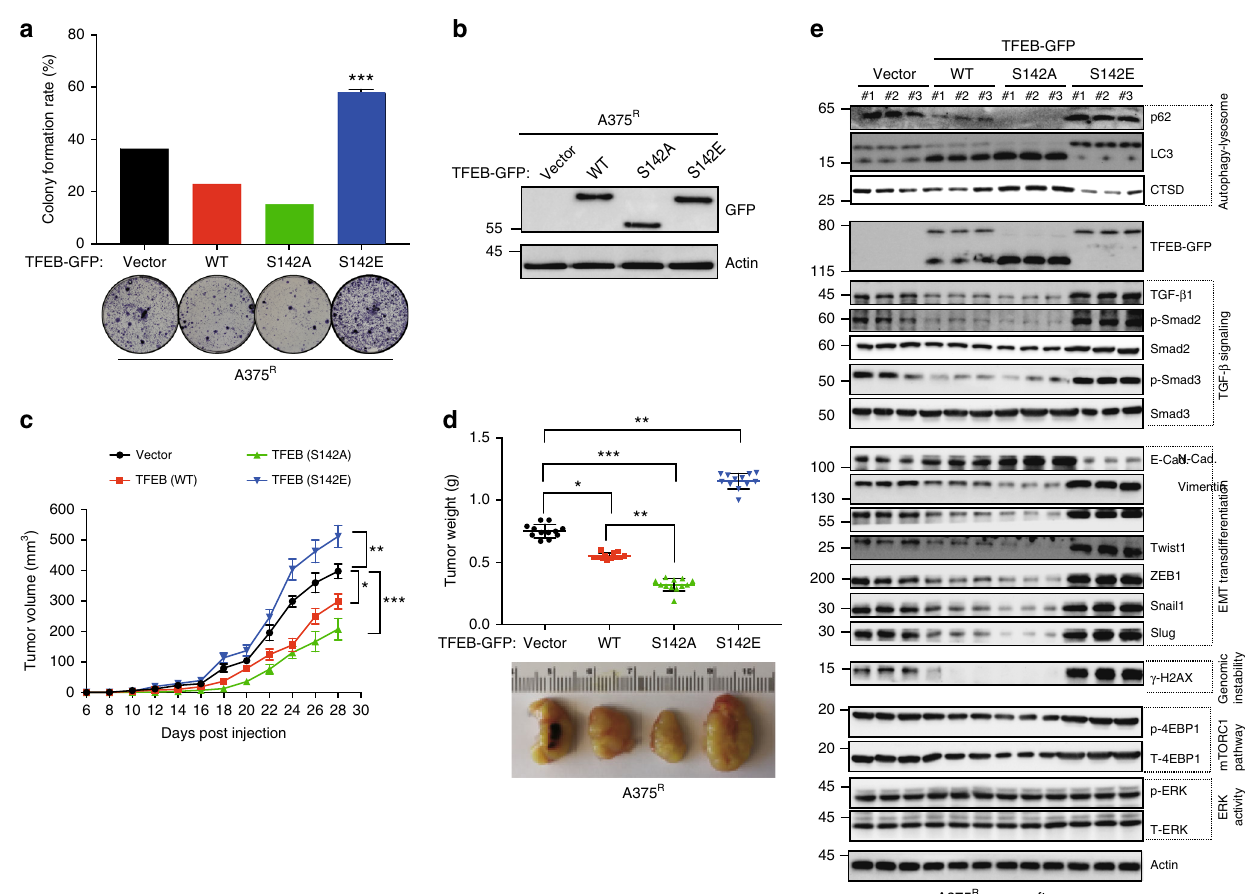
Fig. 7 Effect of TFEB S142 phosphorylation on PLX4720-resistant BRAF V600E melanoma cells. a Colony formation assay of PLX4720-resistant A375 R melanoma cells stably expressing vector, WT TFEB, S142A, or S142E TFEB mutants as indicated. Bars are mean ± SD percentage of colonies for each group after 21 days. n = 3 independent experiments. b Western blot analysis of TFEB expression in cells shown in ( a ). Actin served as a loading control. Data are from one experiment that is representative of three independent experiments. c Tumor volume of xenografts formed after subcutaneous injection of NOD/ SCID mice with A375 R melanoma cells stably expressing the indicated TFEB constructs. Results are the mean volume ± SD for 5 – 6 mice per group per time point. d Tumor weight from experiment shown in ( c ) upon autopsy at day 30. Representative images of tumor size of the indicated A375 R xenograft tumor genotypes are shown below. e Western blot analysis of autophagy (p62 and LC3-I/II), lysosome (CTSD), TGF- β /Smad2/3 signaling, EMT-related [E- cadherin (E-Cad.), N-cadherin (N-Cad.), and Vimentin, Twist1, ZEB1, Snail, and Slug], γ -H2AX, ERK and mTORC1 activation in the indicated xenografts (three randomly chosen samples per group; similar results observed in all 10 – 12 samples per condition). Actin served as a loading control. See Supplementary Fig. 13 for uncropped data. For all quanti fi cation, data represent the mean ± SD derived from indicated number of independent experiments. Comparisons were made using Student ’ s t -test. * P < 0.05; ** P < 0.01; *** P <